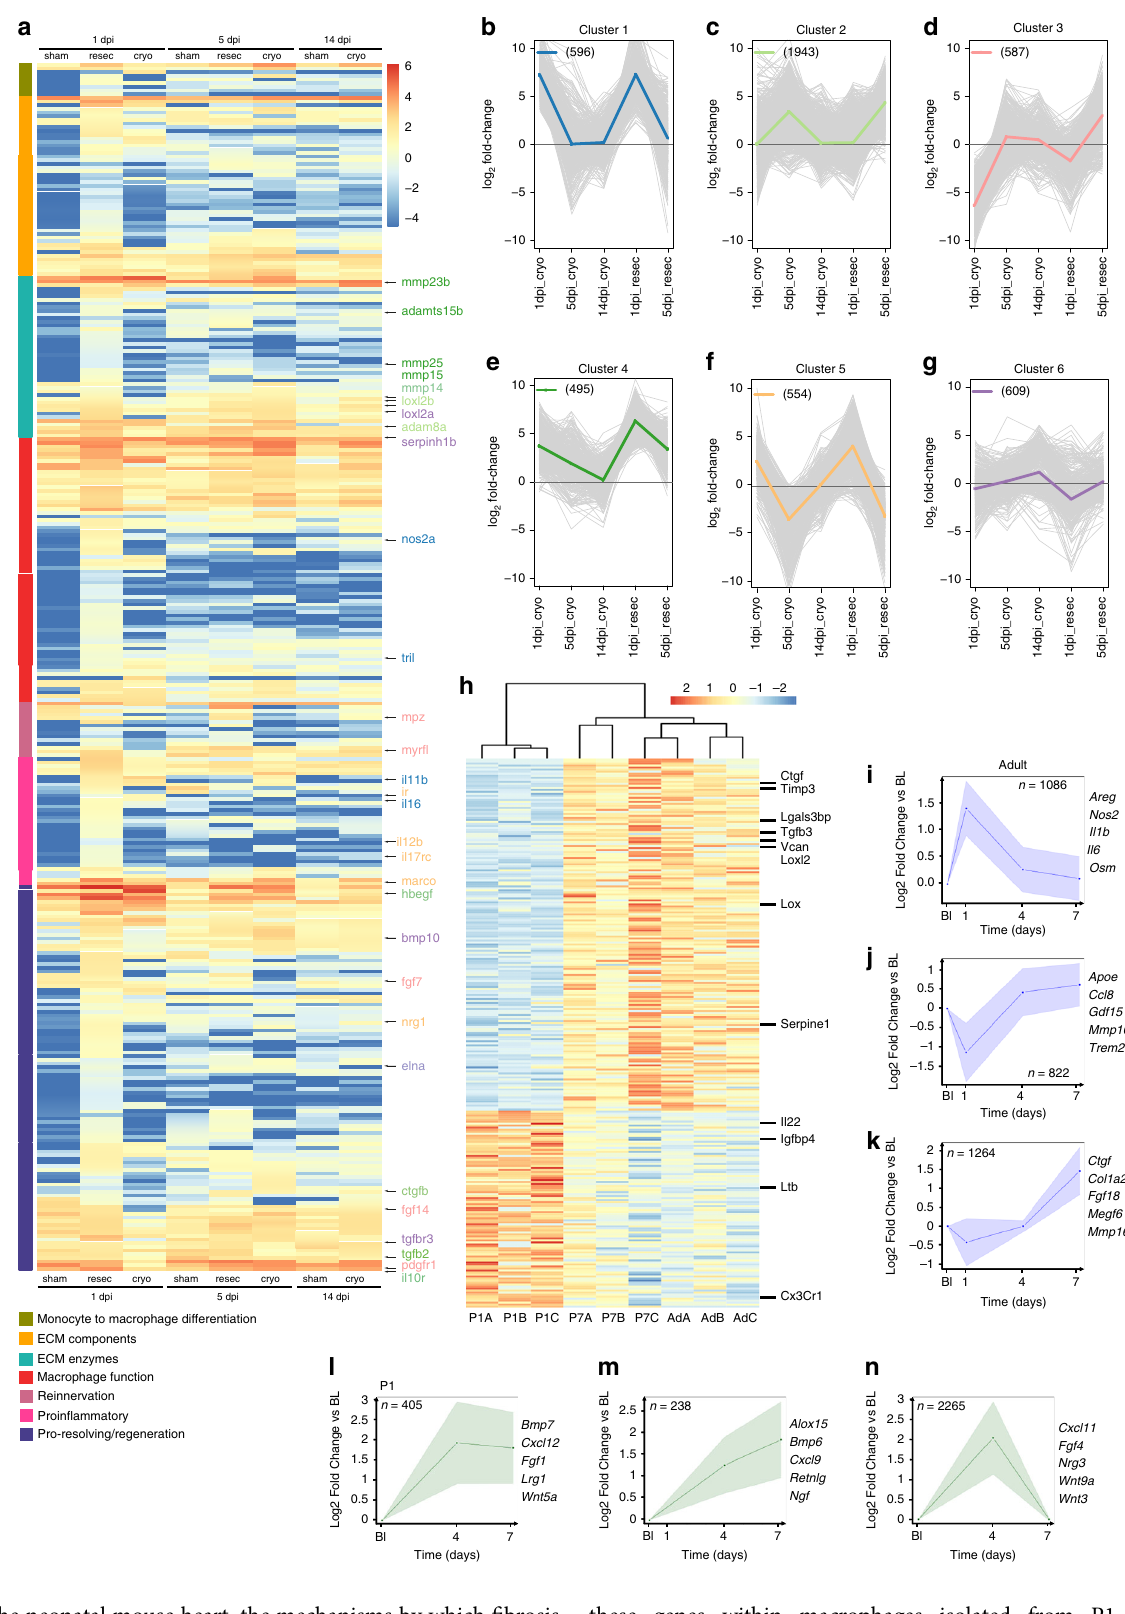
Monocyte to macrophage differentiation ECM components ECM enzymes Macrophage function Reinnervation Proinflammatory